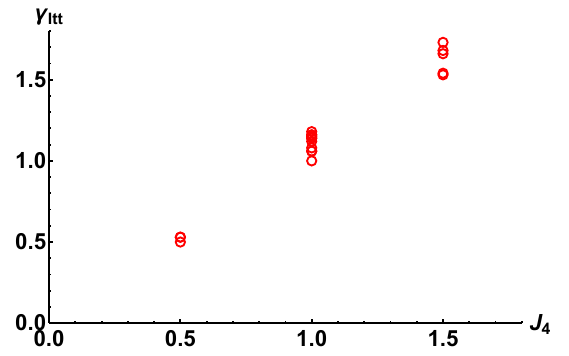
Figure 8. The exponent (cid:13) Itt as a function of J 4 .